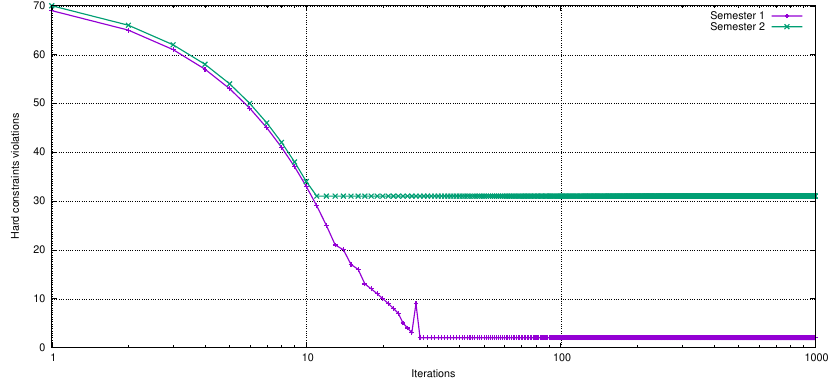
Figure 16. Solving the hard constraints in the ACA phase (logarithmic